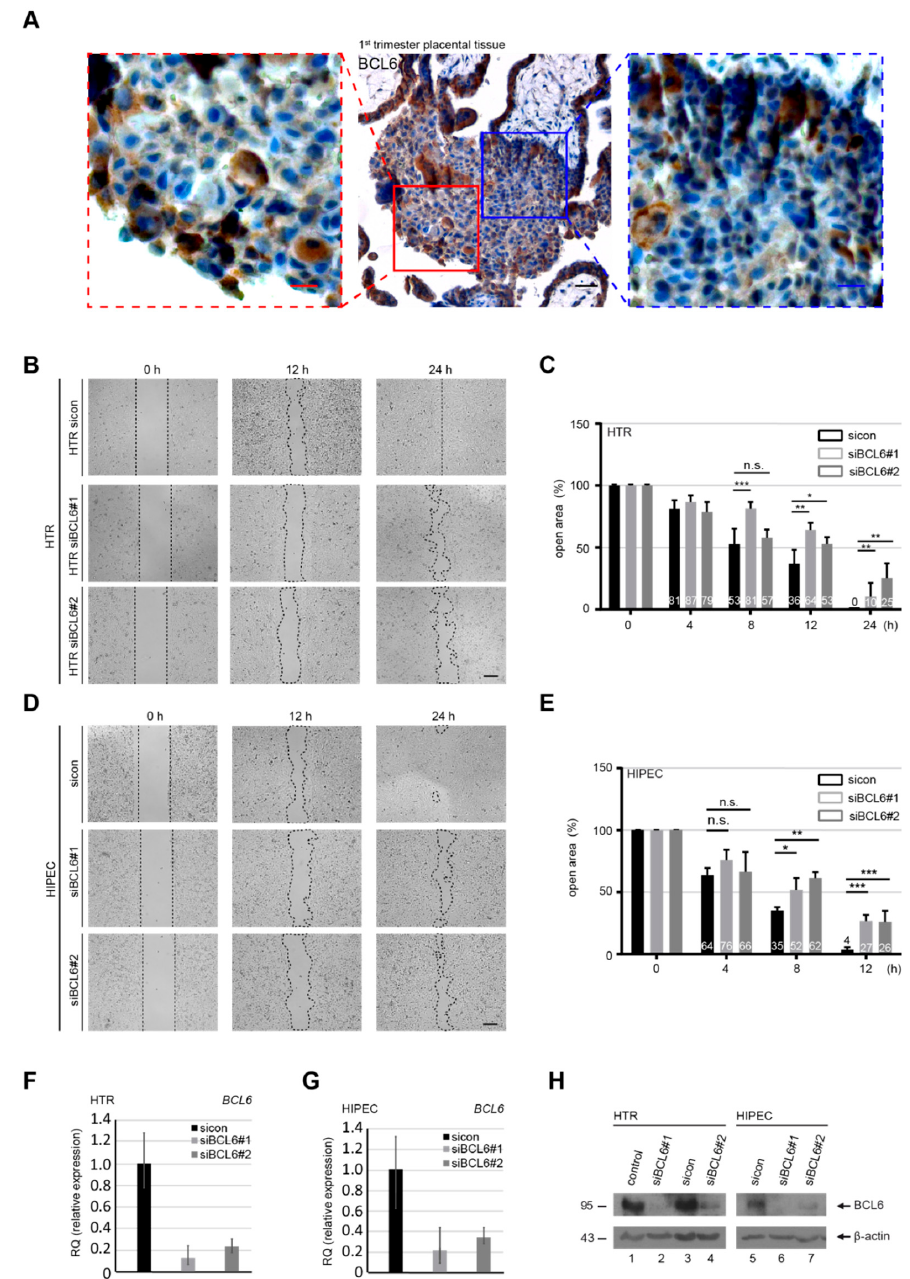
Figure 1. Abundance of B-cell lymphoma 6 (BCL6) in first trimester placentas and requirement for the migration of trophoblastic cells. ( A ) First trimester placental tissue sections were immunohistochemically stained for BCL6 and DNA. Representatives are shown. Scale: 50 µm, inset scale: 20 µm. ( B , D ) HTR-8/SVneo (HTR) ( B ) or HIPEC-65 (HIPEC) ( D ) cells were treated with control siRNA (sicon) or two different siRNAs targeting the coding region of BCL6 (siBCL6#1 and siBCL6#2) for 12 h. Treated cells were subjected to wound healing/migration assays. Migration front closure was imaged at 0, 8, and 12 h and bright-field images are shown. The migration front is visualized by black dashed lines. Scale: 300 µ m. ( C , E ) The open areas of HTR ( C ) or HIPEC ( E ) cells were quantified and are presented in a bar graph at multiple time points. The reference point was the cell-free area at 0 h, which was set as